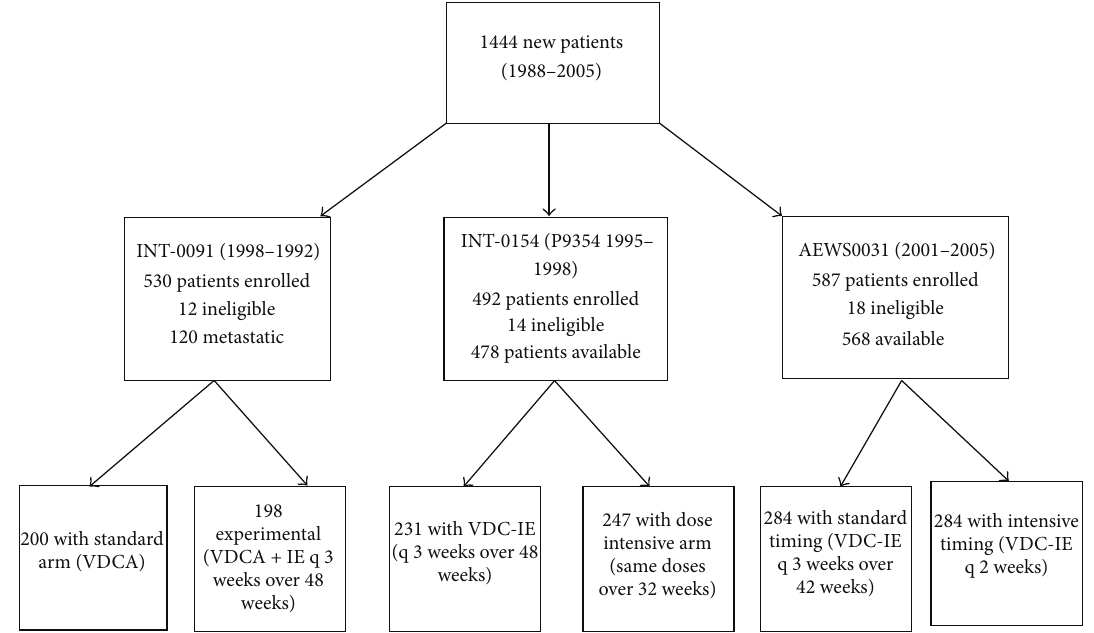
Figure 1: CONSORT diagram for 1444 patients enrolled in three consecutive COG studies. The arms to which patients were randomized are shown along with exclusion criteria and those patients who were thereby ineligible. CONSORT = Consolidated Standards of Reporting Trials; COG = Children’s Oncology